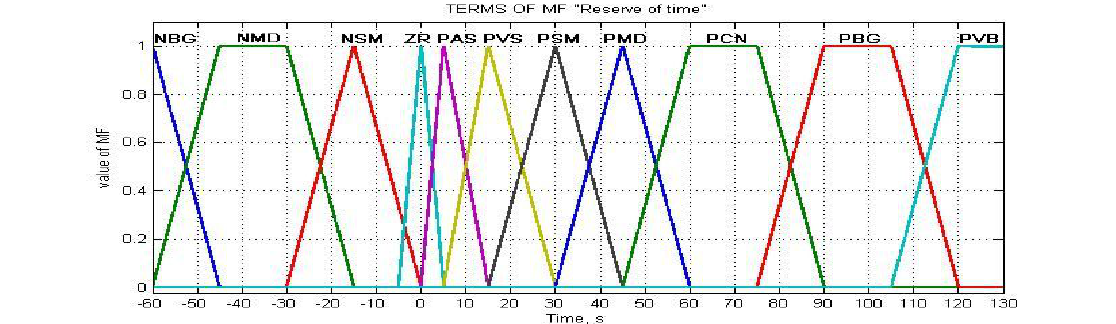
Fig. 8. Term-sets NBG, NMD, NSM, ZR, PAS, PVS, PSM, PMD, PCN, PBG, PVB of linguistic variable “Reserve of time" Table 1. The base of production rules for fuzzy